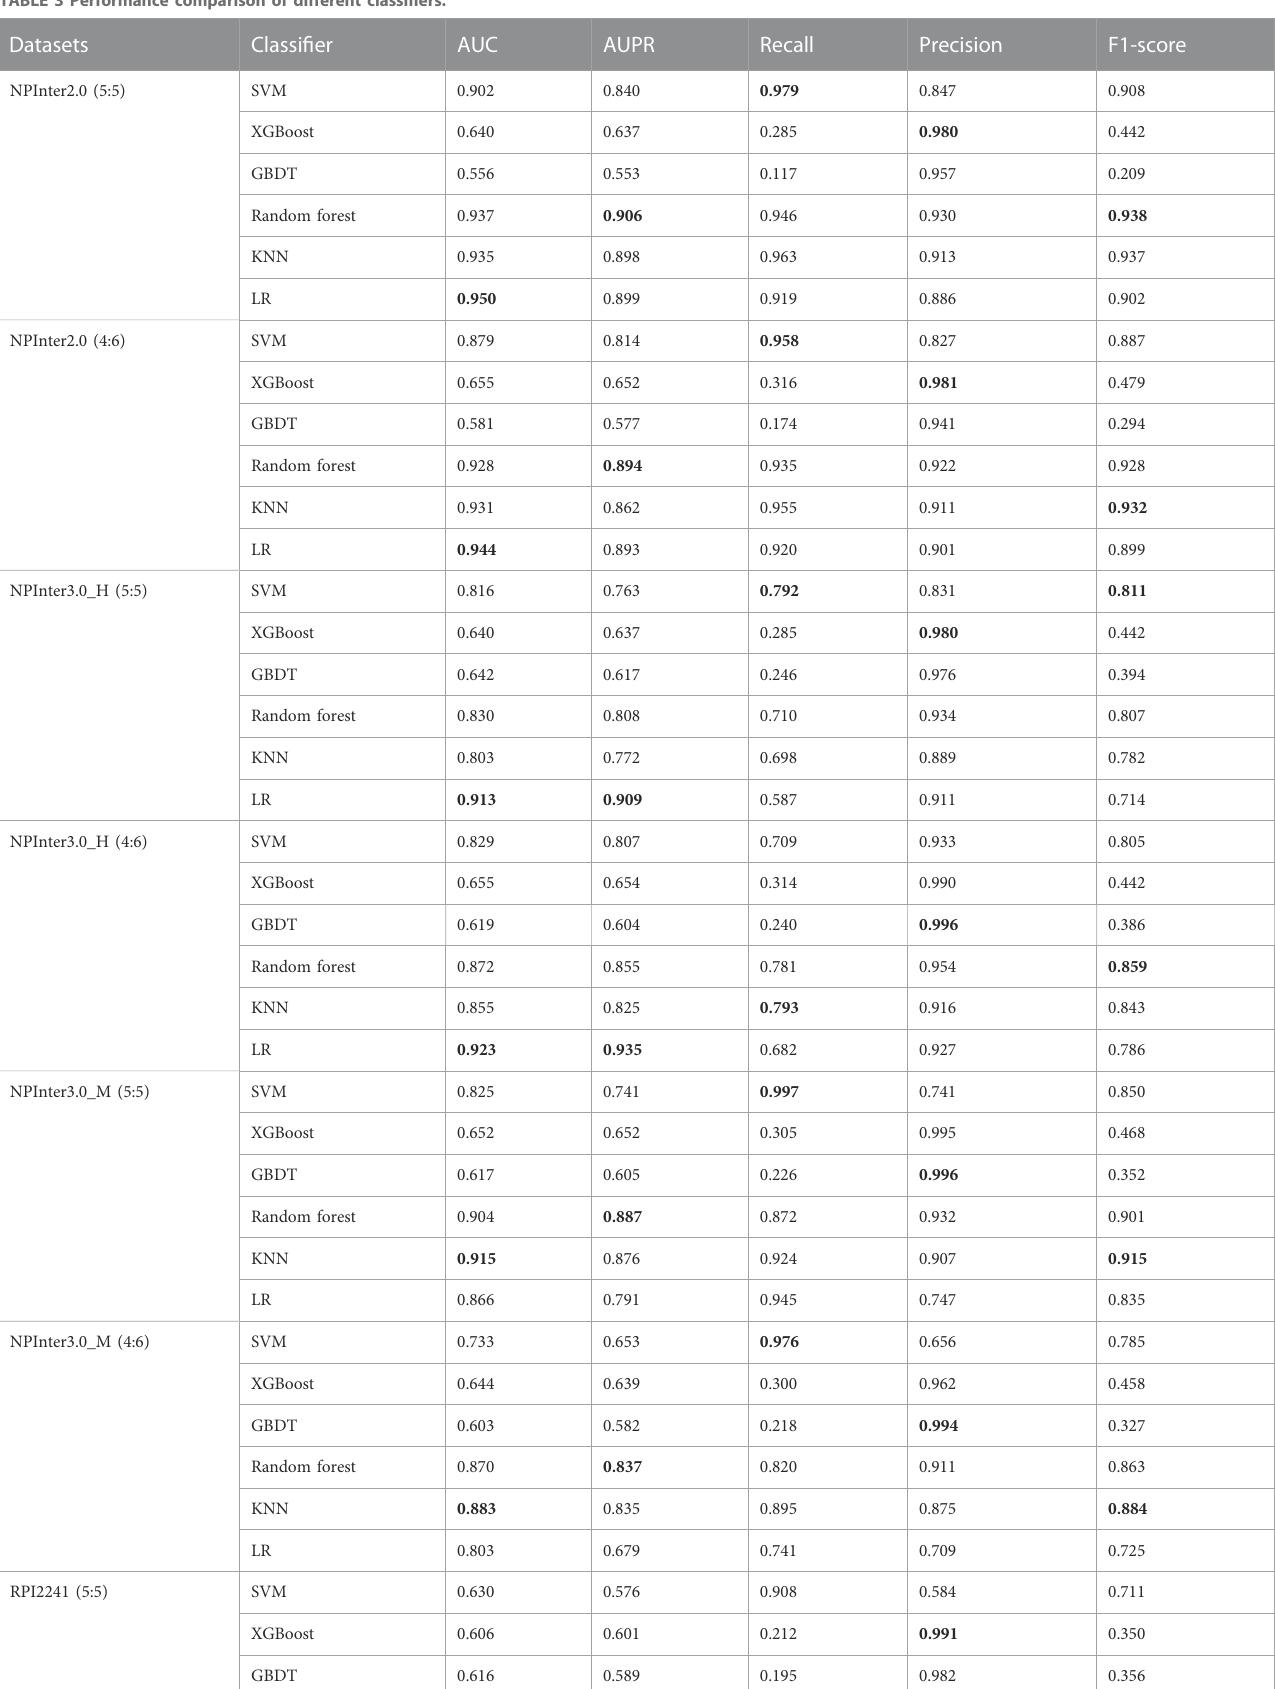
TABLE 3 Performance comparison of different classi fi